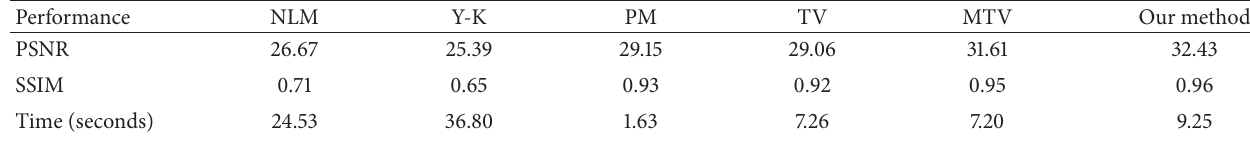
Table 1: PSNR and SSIM comparisons with different methods for the synthetic image ( 256 × 256 ).